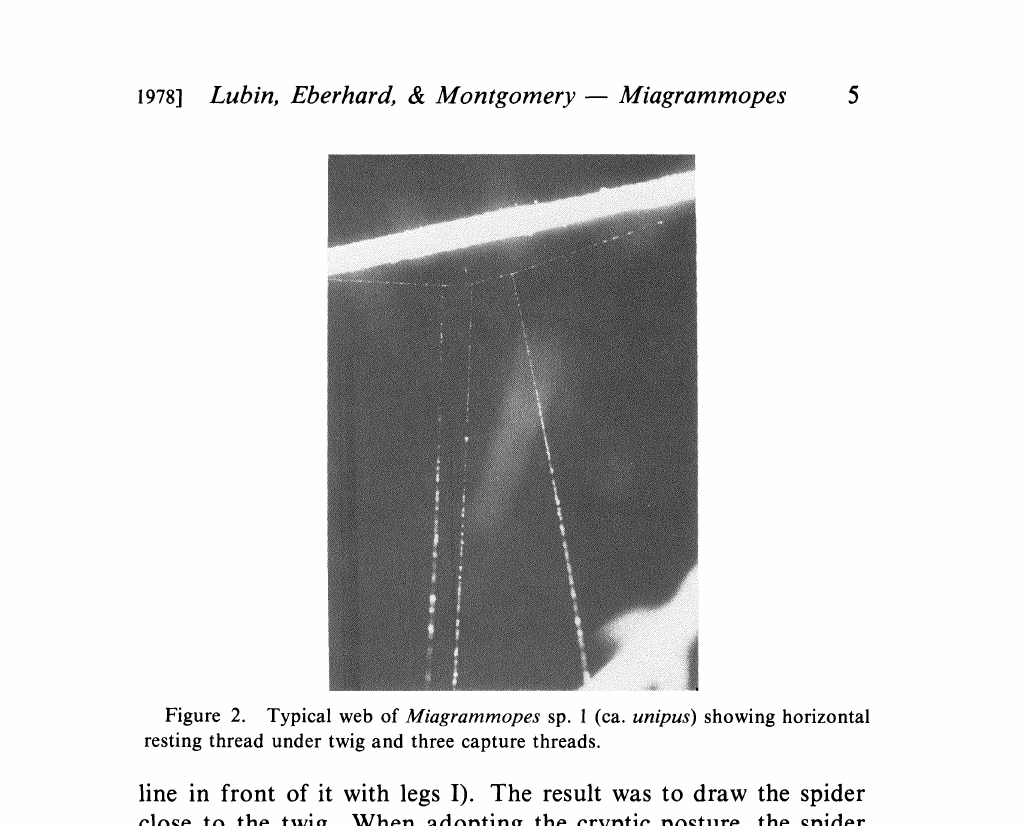
Figure 2. Typical web of Miagrammopes sp. (ca. unipus) showing horizontal resting thread under twig and three capture